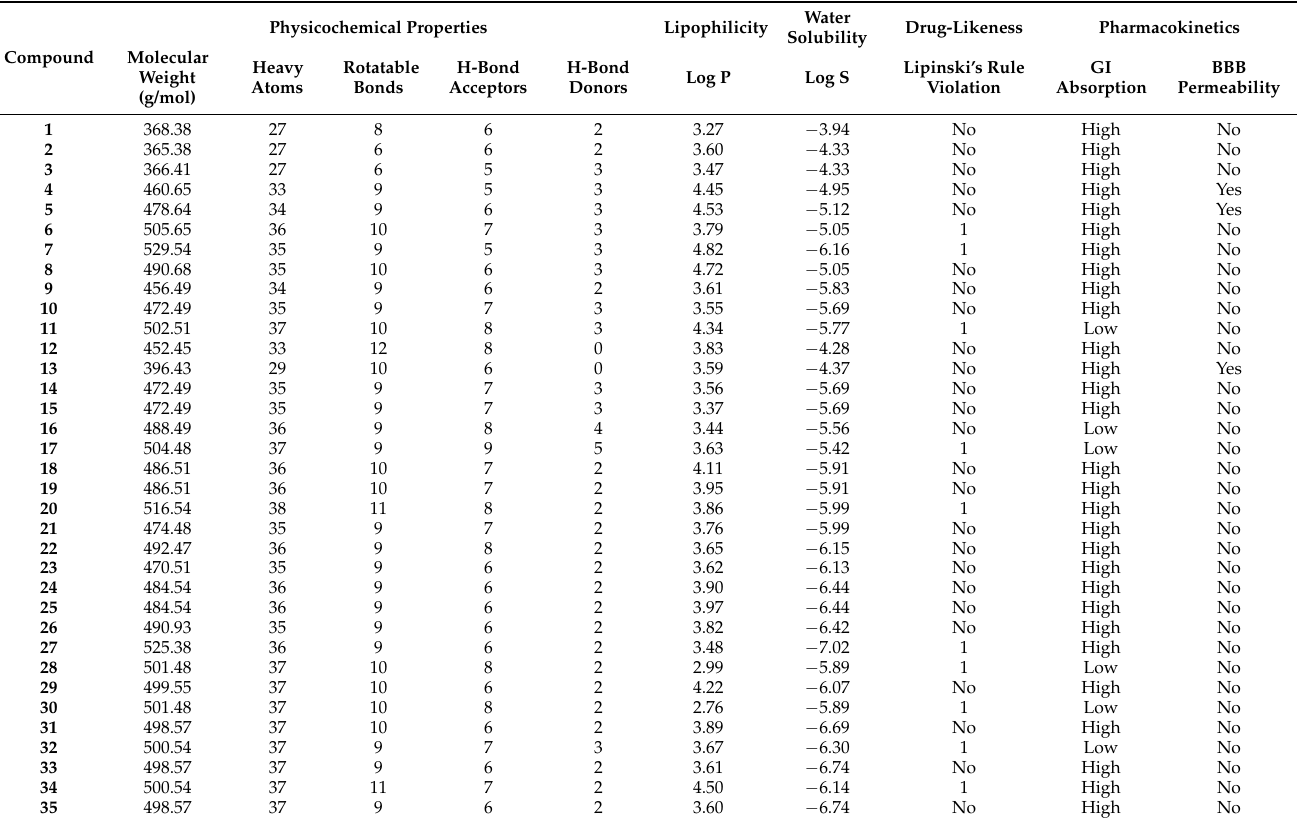
Figure 9. Chemical structures of curcumin derivatives, which have been synthesized and studied for their anti-inflammatory and antimalarial activities [23,47]. Table 1. Physicochemical and pharmacokinetic properties of each compound shown in Figure 7, as generated by the Swiss ADME server [62].